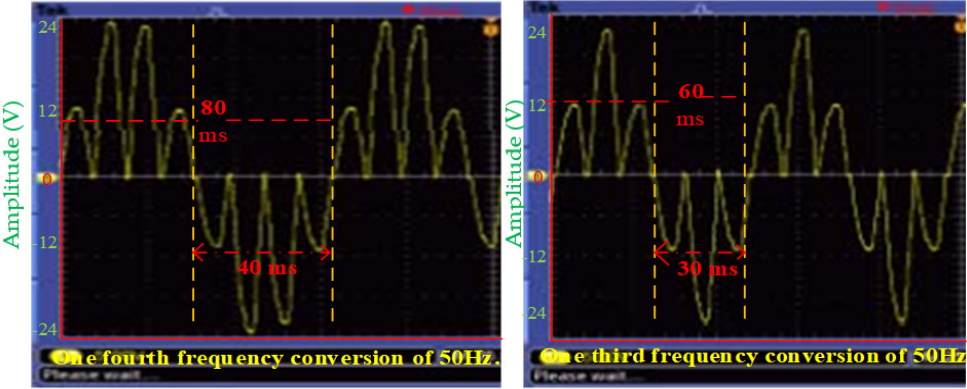
Figure 16. Physical experiments output responses of proposed cycloconverter for one-fourth fre- quency conversion on the left and one-third frequency conversion on the right.